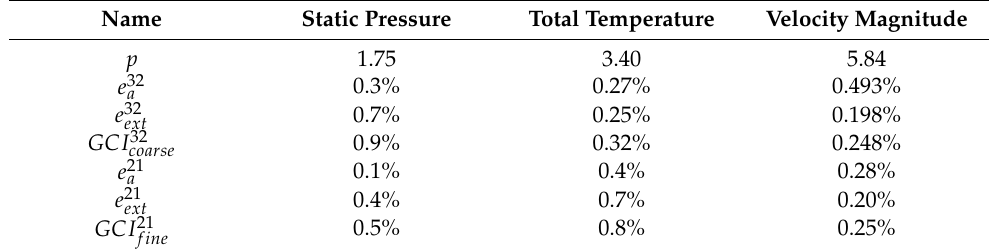
Table 3. Mesh convergence study